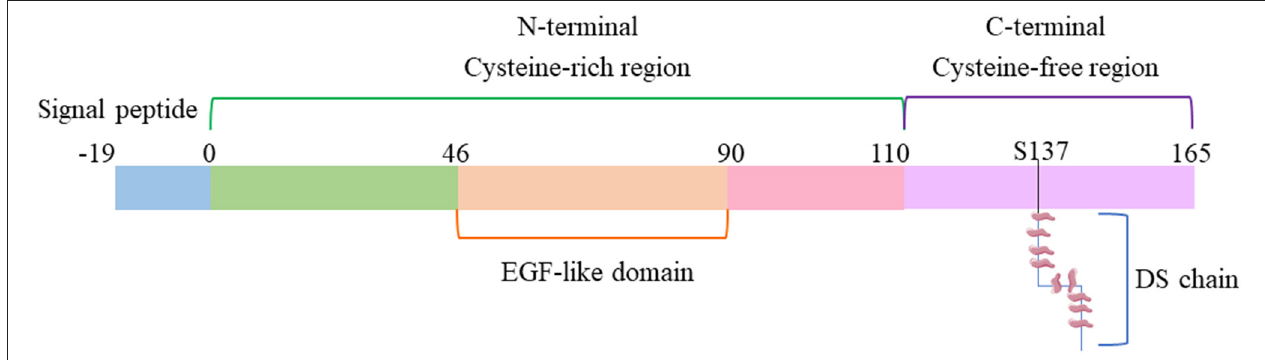
FIGURE 1 | Schematic diagram of endocan structure. DS, dermatan sulfate; EGF, Epidermal Growth Factor.